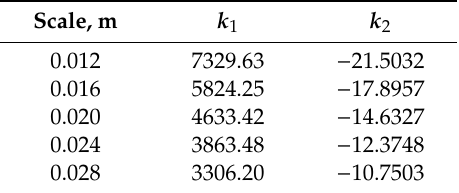
Table 1. Coe ffi cients of regression model (1) for the base frequency. Scale, m k